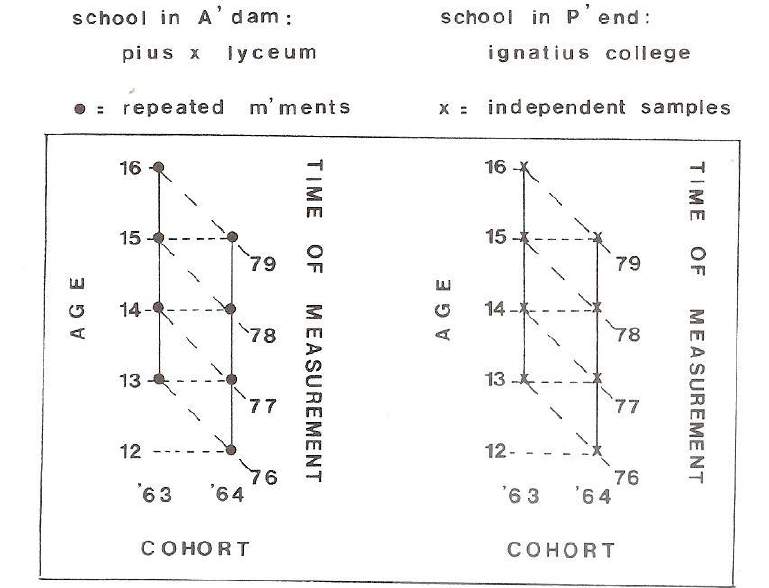
Figure 3. Multiple longitudinal design of Amsterdam Growth And Health Longitudinal Study (AGAHLS) in the two schools: Pius X Lyceum in Amsterdam (two birth cohorts (1963 and 1964) with repeated measurements) and Ignatius College in Purmerend (two birth cohorts (1963 and 1964) with independent samples) [8].